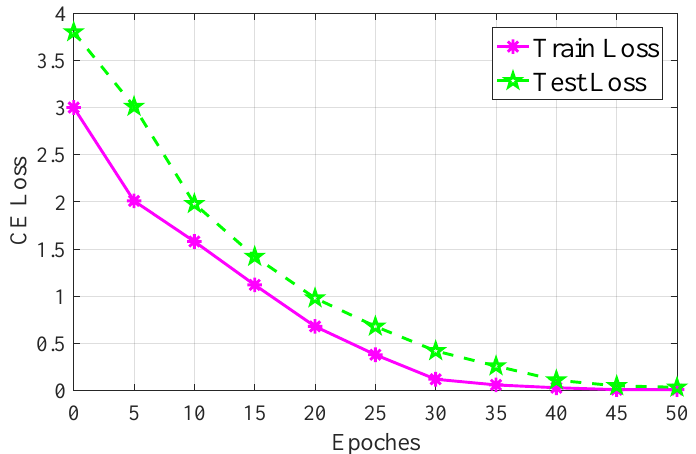
Figure 8. This figure shows the training result of the GCN modal. The peach line represents the train loss and the green line represents the test loss. As seen from the figure, the train loss decreases sharply in the first 25 epochs, and slowly in the last 10 epochs until the loss value reaches 0.0098 after 40 epochs. The test loss decreases sharply in the first 20 epochs, and the loss value reaches 0.13 after 45 epochs, and the loss value of the last 3 epochs increases